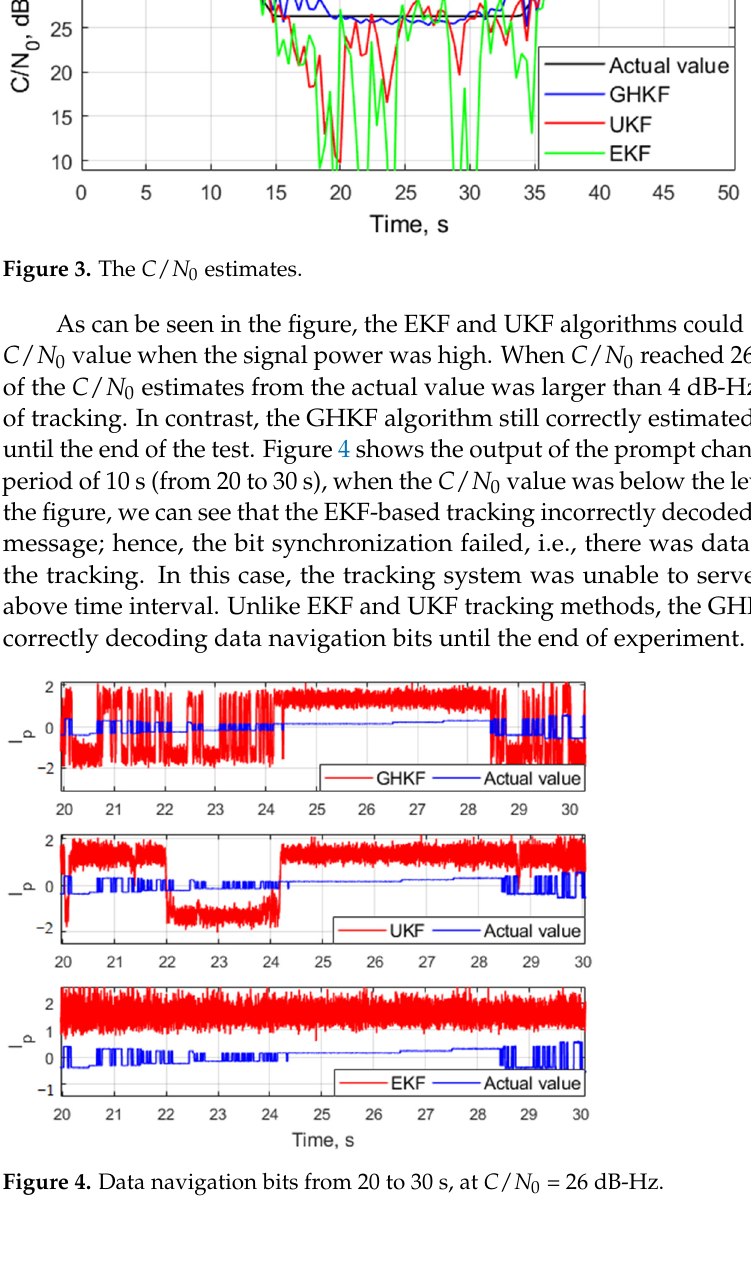
Figure 4. Data navigation bits from 20 to 30 s, at